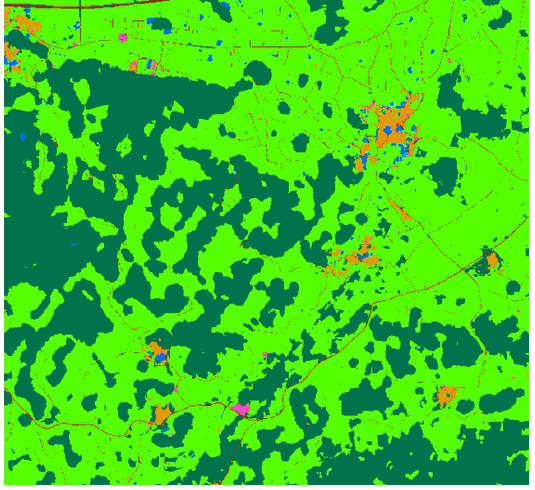
Fig. 7 Result of Classification 8 models, including heterogeneous model convolutional neural network, FCN16s (cid:18) AttU_Net and DenseASPP, are used as primary learners. And the 8 heterogeneous models are trained separately using the training set of balanced classes after data augmentation. which is shown in the following table. Table 3 Contrast on the Classification Accuracy of Land Cover